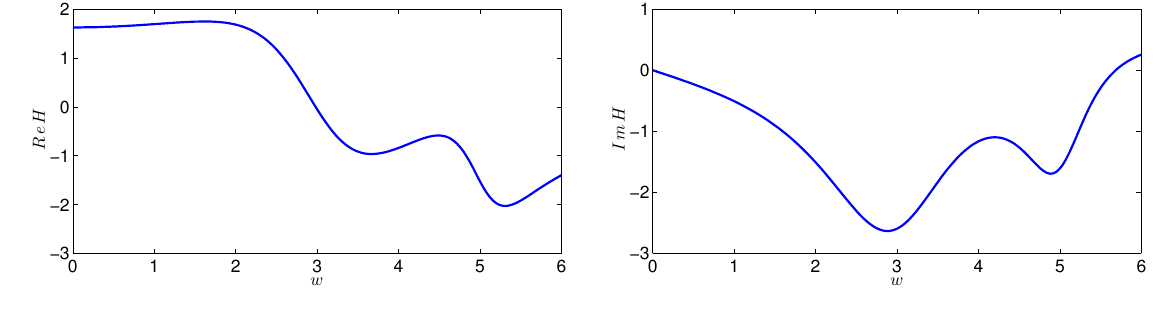
Figure 1. Re H ( w ) and Im H ( w ) in the four-pole example.